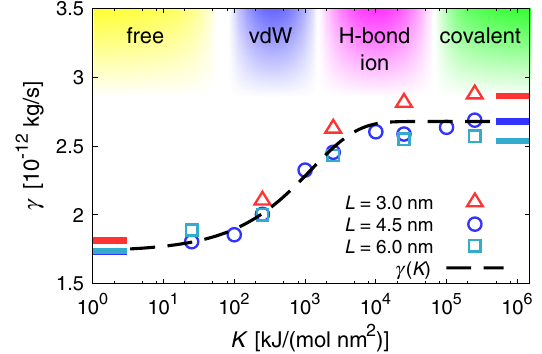
FIG. 4. Friction coefficient. Results for γ from the best-fit friction kernels are shown as a function of K for three simulation box sizes L . Statistical errors are of the order of the symbol size. The results for K ¼ 0 and K ¼ ∞ are obtained from free diffusion and frozen simulations and denoted by horizontal colored lines. For L ¼ 4 . 5 nm an empiric fit is included (dashed